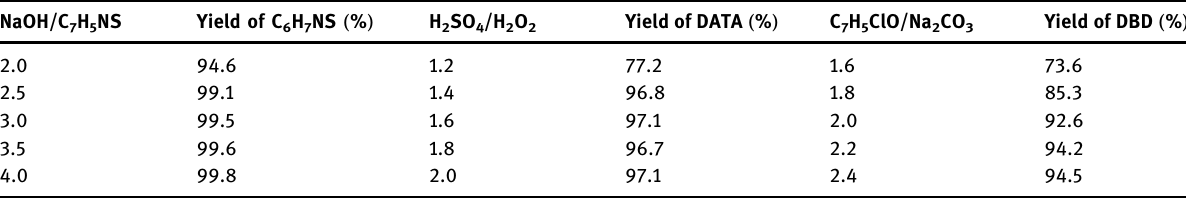
Table 1: E ff ect of reactant ratio on reaction yield NaOH/C 7 H 5